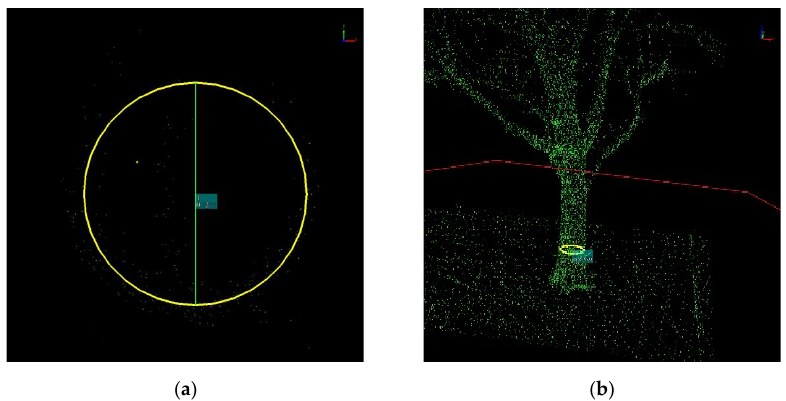
Figure 8. Cross-sections of point cloud maps: ( a ) circle fitting; ( b ) 10 cm-thick sections.